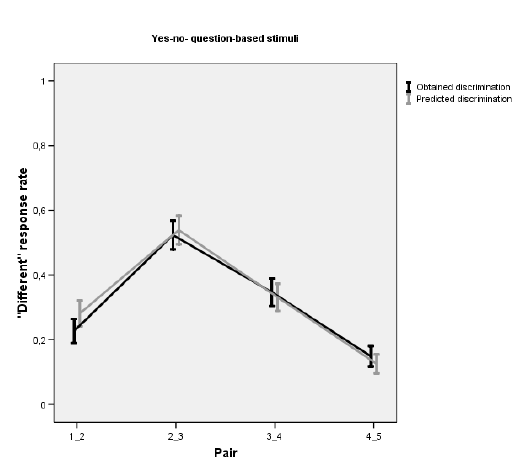
Figure 10. Predicted and obtained discrimination rates for the continuum created from the yes-no question base stimulus Error bars represent the standard error of the